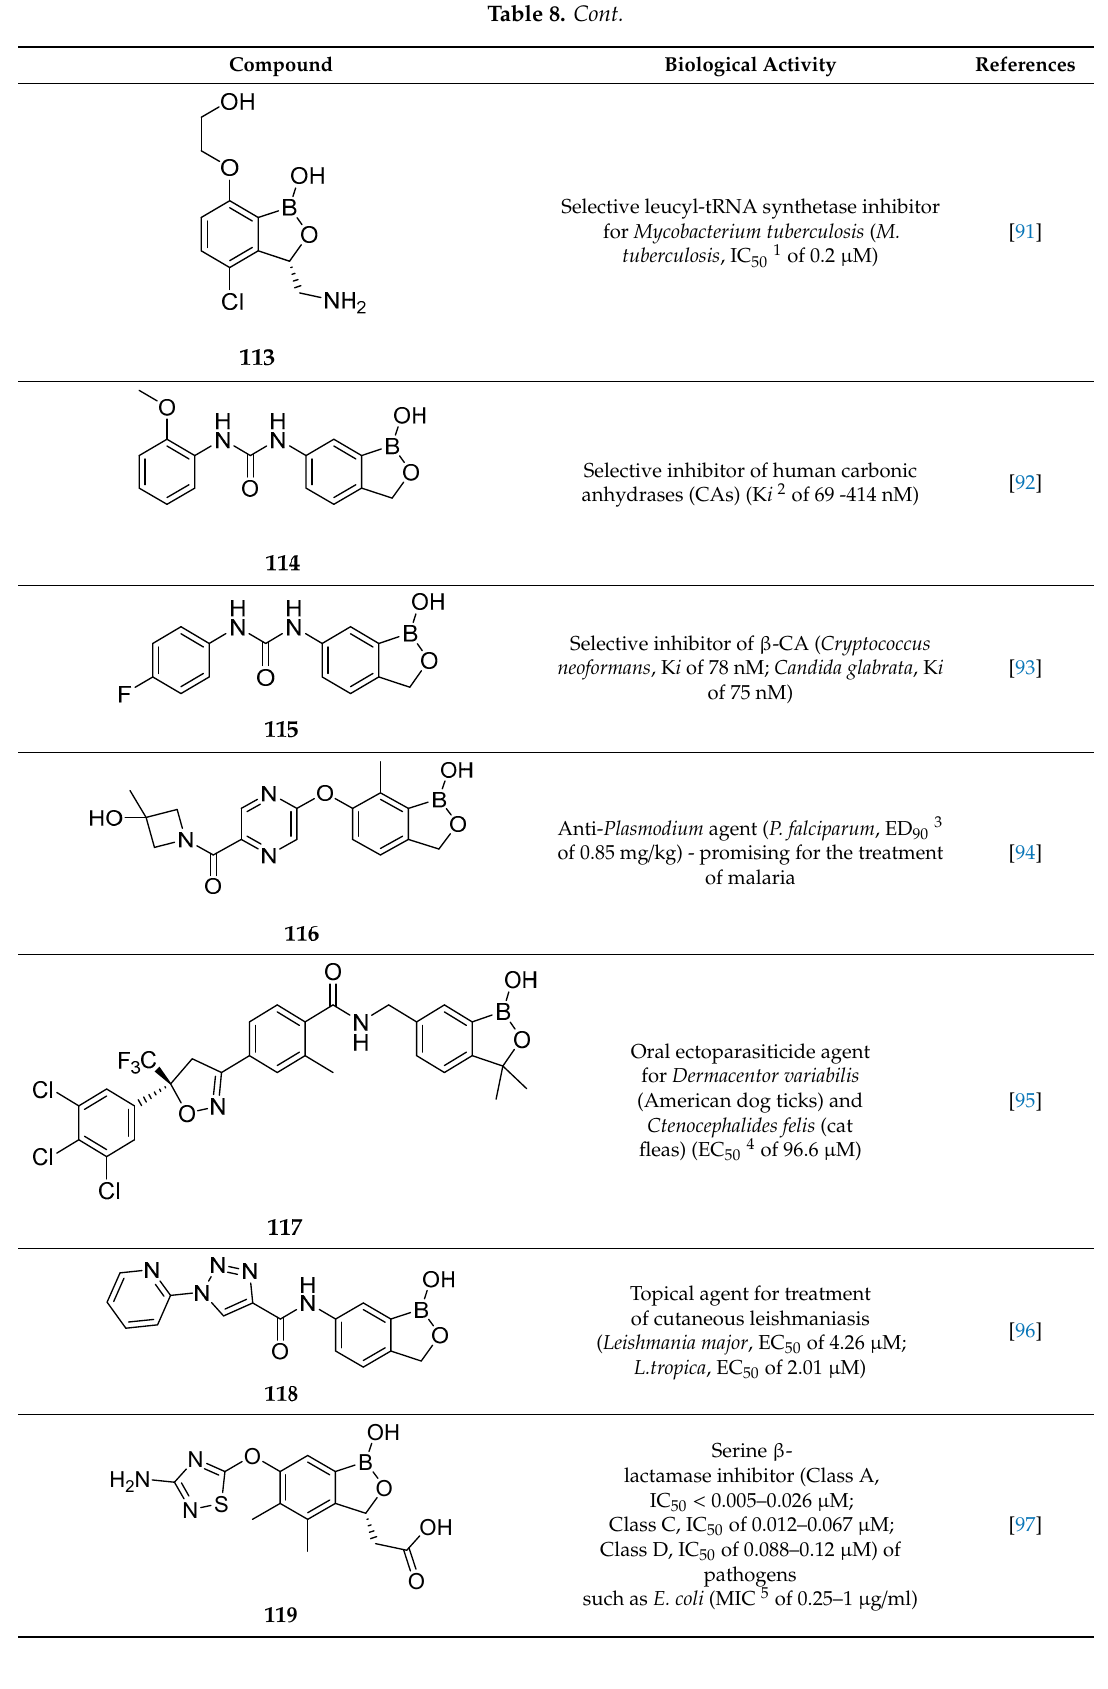
Table 8. Examples of known biological activities of benzoxaborole compounds.